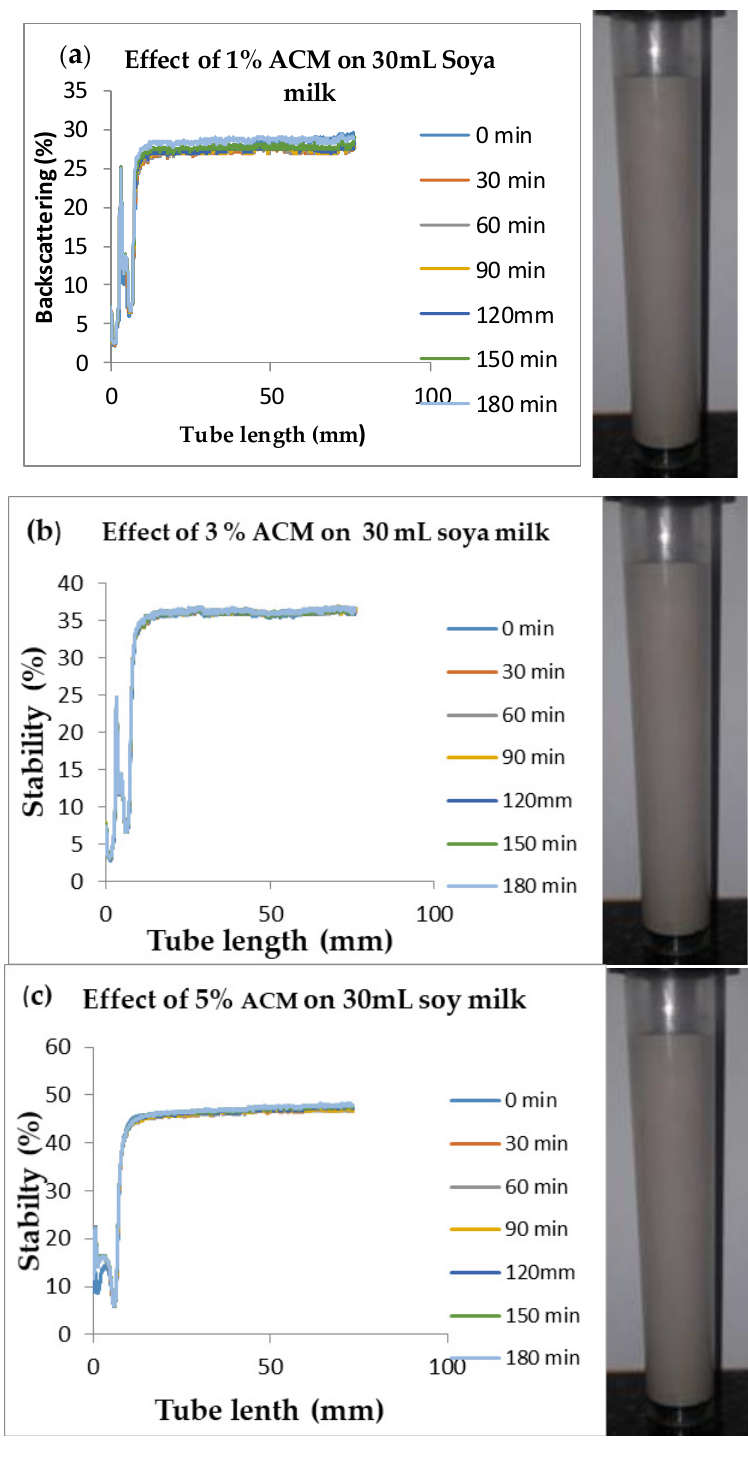
Figure 4. Changes in stability of ACM-stabilized 30 mL ( w / w ) soya milk emulsions ( a ) 1 g w / w ; ( b ) 3 g w / w ; ( c ) 5 g w / w African catfish mucus.